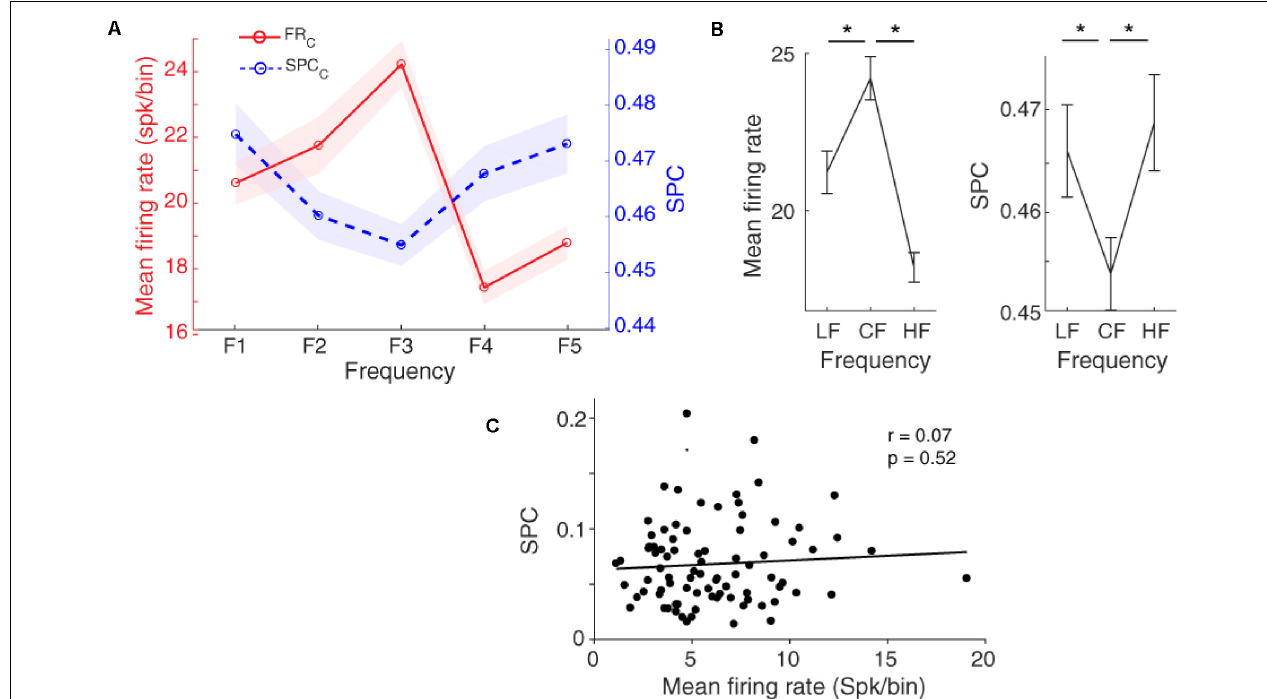
FIGURE 4 | Spike-phase coupling (SPC) tuning curve. (A) The firing rate and SPC strength relative to different stimulus frequencies averaged for the population of neurons. The x -axis shows different frequencies and the y -axes represent the normalized spike rate (red solid curve) and SPC strength (blue dashed curve). Resembling the firing rate with a bell-shaped tuning curve, the SPC strength relative to different stimuli follows an inverted bell-shaped tuning curve. Shaded areas show SEM. (B) Statistical comparison of the firing rate (left panel) and SPC (right panel) between the characteristic frequency (CF) and its neighboring frequencies (LF, HF). Stars show a significant difference (Wilcoxon rank-sum test, p < 0.05). LF is F1 and F2 responses, and HF is related to F4 and F5 responses. (C) The correlation between mean firing rate and mean SPC across different recording neurons. No significant correlation between them was observed (Pearson’s correlation, p > 0.05).